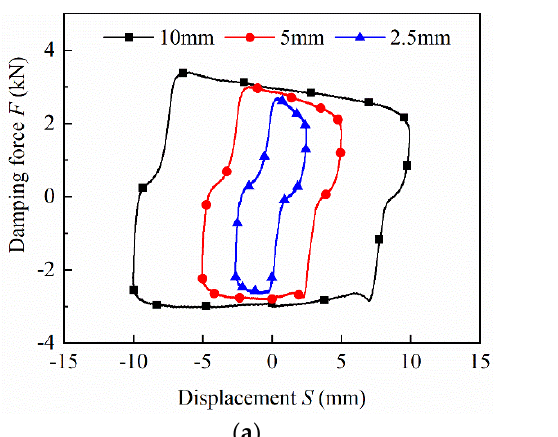
15 of 21 Figure 15. Performance test rig of MR damper: 1. vibration excitation platform, 2. tested MR damper, 3. controlled computer, 4. DC power supply, 5. electrohydraulic servo controller [31]. 5.2. Experimental Analysis of Damping Performance Figure 16 shows the output damping force of the initial and optimal MR dampers with the input current of 1 A and sinusoidal displacement excitation with the same